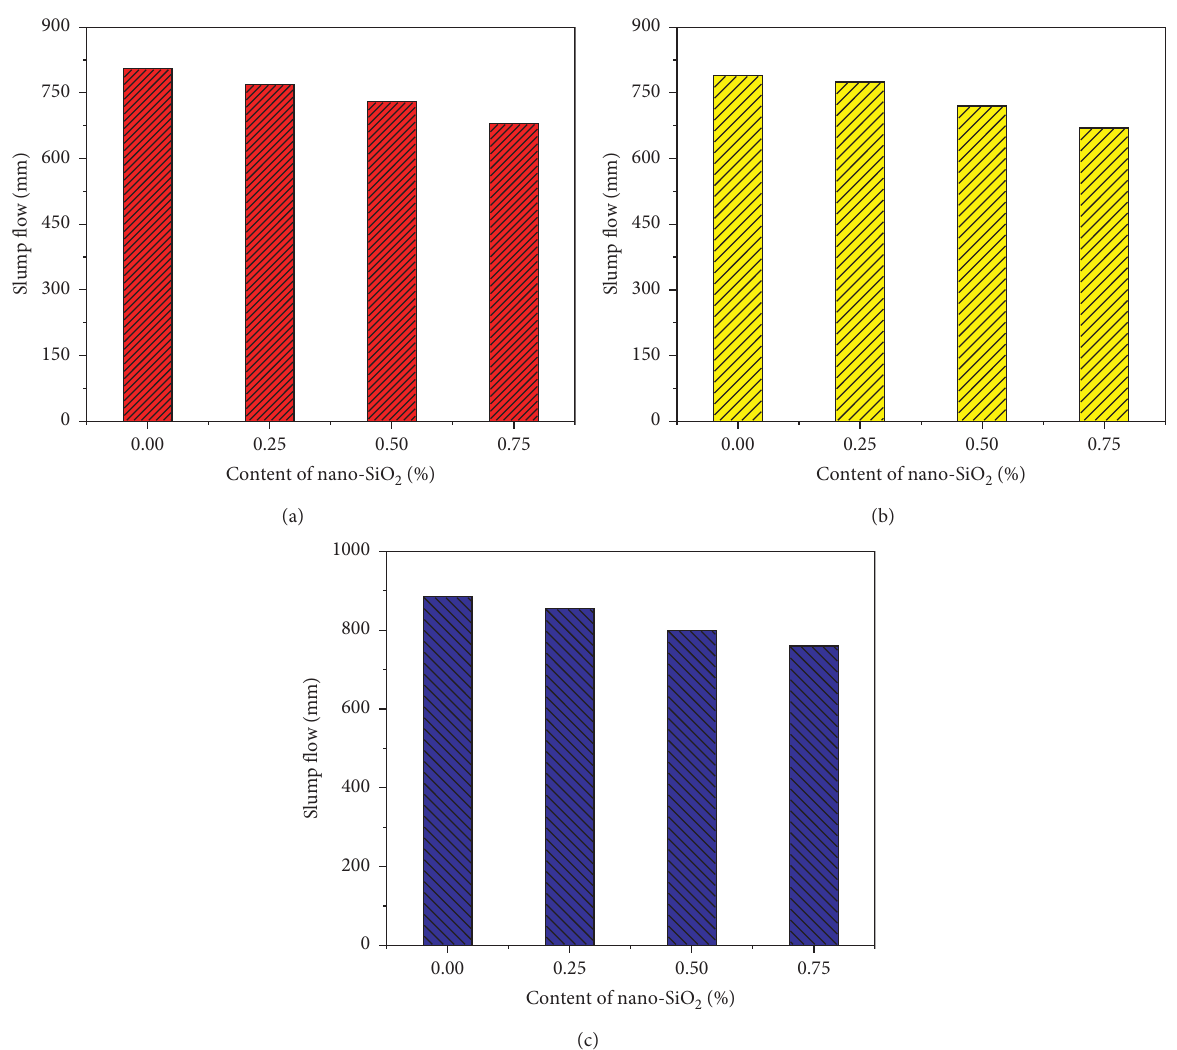
Figure 2: Relationship between the slump flow and w/b [47]. (a) w/b � 0.45; (b) w/b � 0.41; (c) w/b �